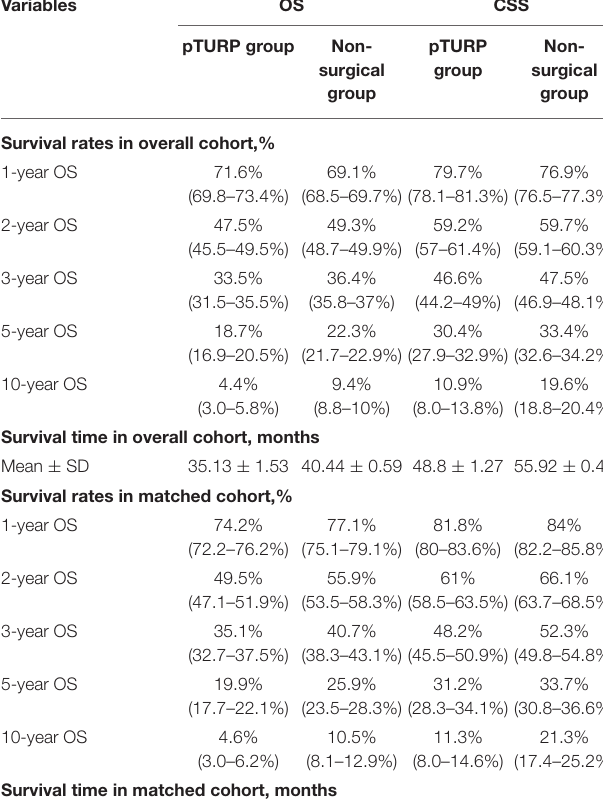
TABLE 2 | The survival rates and survival time in the TURP group and non-surgical group in the overall cohort and matched cohort. Variables